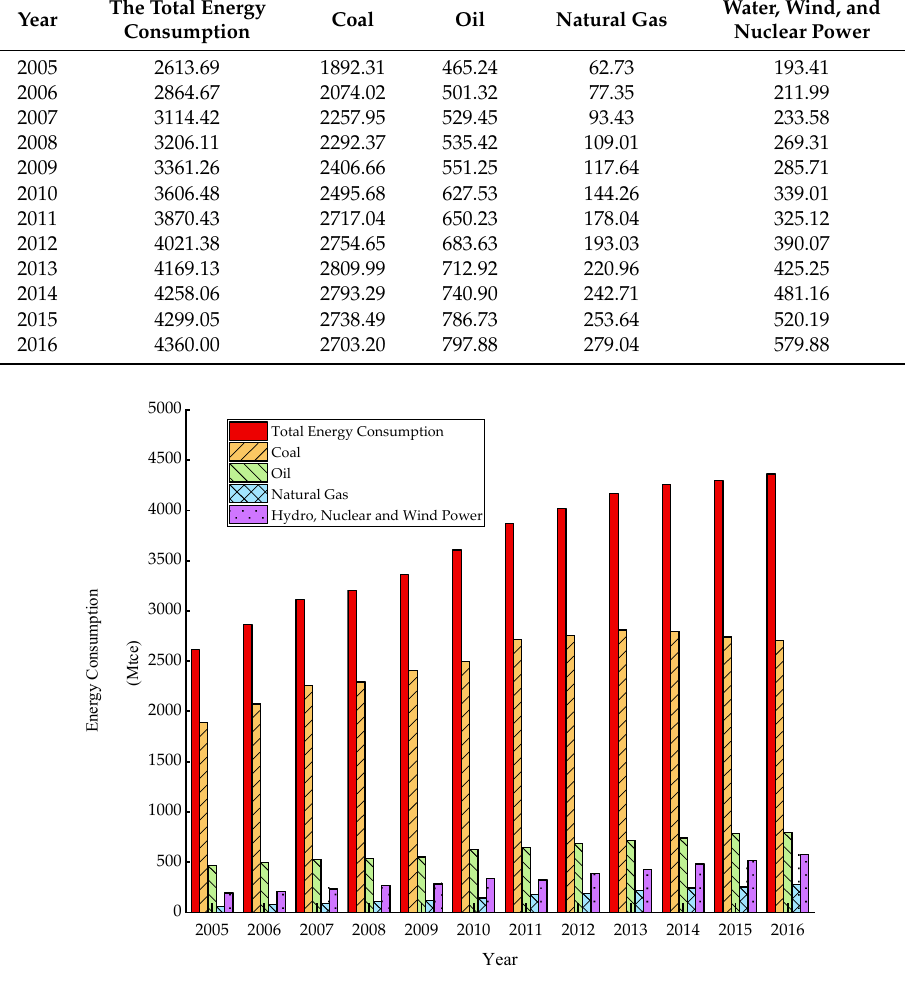
Figure 6. Energy consumption in China from 2005–2016.